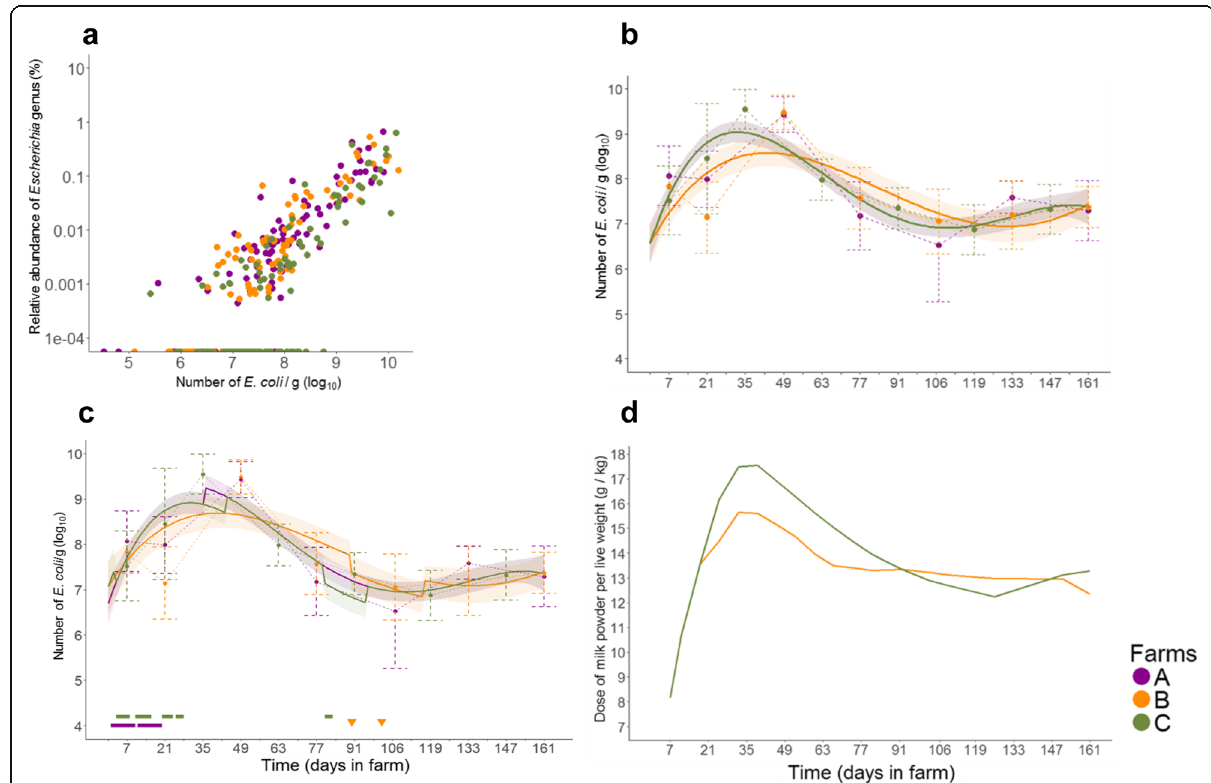
Fig. 7 Absolute quantification of the Escherichia coli population by qPCR. a Relative abundance of the Escherichia genus as a function of the number of E. coli /g estimated by qPCR. Each point represents a sample. Points on the x-axis represent samples for which no 16S rRNA gene sequence of the Escherichia genus was detected by sequencing. b Dynamics of the mean observed and predicted number of E. coli /g for each farm in the final model without the antibiotic-treatment effect. The mean values ± standard deviations of the observed data for each farm at each sampling time are represented by the dashed bars. The model-predicted profiles and their 95% confidence bands are represented by the solid lines and bands, respectively. The predicted profiles of farms A and C are overlapping, which is why the predicted profile of farm A does not appear. c Dynamics of the mean observed and predicted number of E. coli /g for each farm in the final model with the antibiotic-treatment effect. Antibiotic treatments during sampling or within 15 days before sampling are color-coded by farm and indicated above the x-axis. d Temporal dynamics of the recommended dose of milk powder per kilo of live weight for farms B and